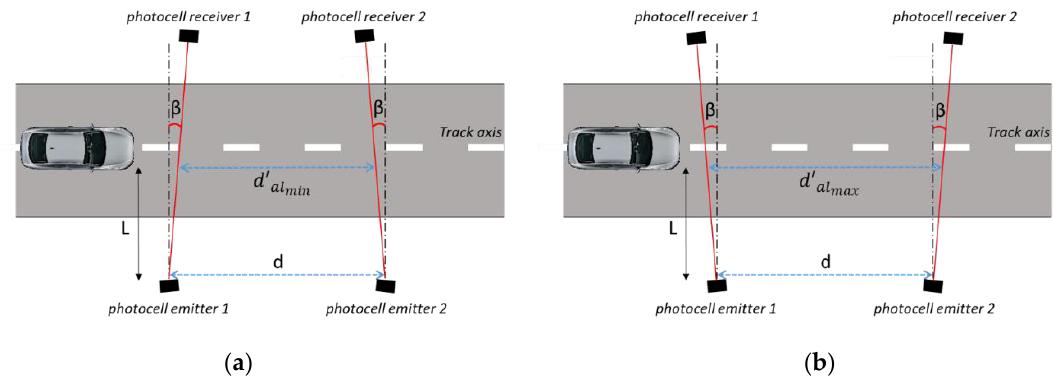
Figure 5. Uncertaintycontributionsduetotheerrorintotheinstallationofthephotocellstransmitter-receiver